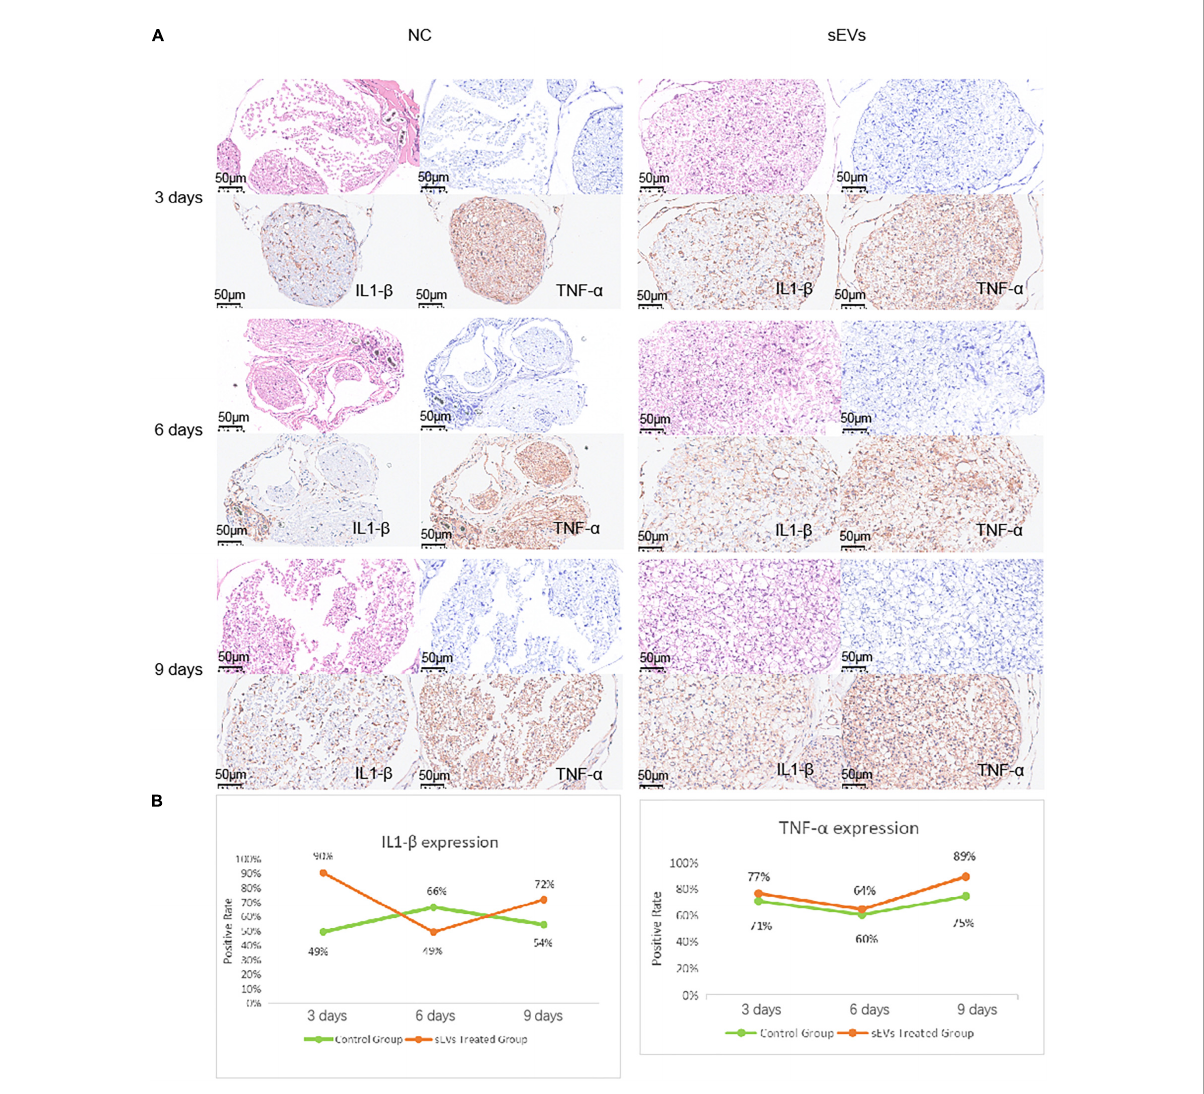
FIGURE5 Sciatic nerve injury and pathological injury upon treatment. (A) Histological examination of sciatic nerve injury: Tissues from both the control and treated groups were sectioned at the 3-day interval to examine the extent of the injury. HE staining: deeply purple-stained nuclei and lightly stained pink cytoplasm. Toluidine blue staining: Darkly stained indigo nuclei. (B) Immunohistochemical analysis of IL1- β and TNF- α was carried out with antibodies (refer to note in the lower right corner), and the antibody dilution was set at 1:3,000 based on preliminary experimental